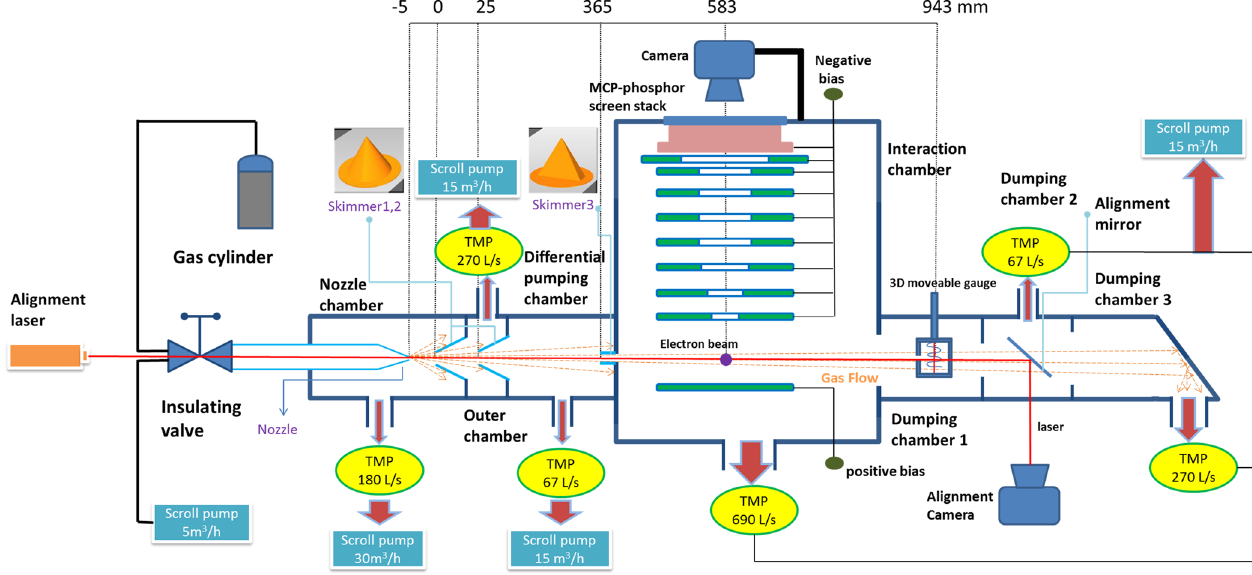
FIG. 2. General overview of the gas jet monitor setup (TMP: turbomolecular pump. The pumping speed is based on N 2 gas. TMPs for the outer and differential pumping chambers are backed by the same scroll pump).